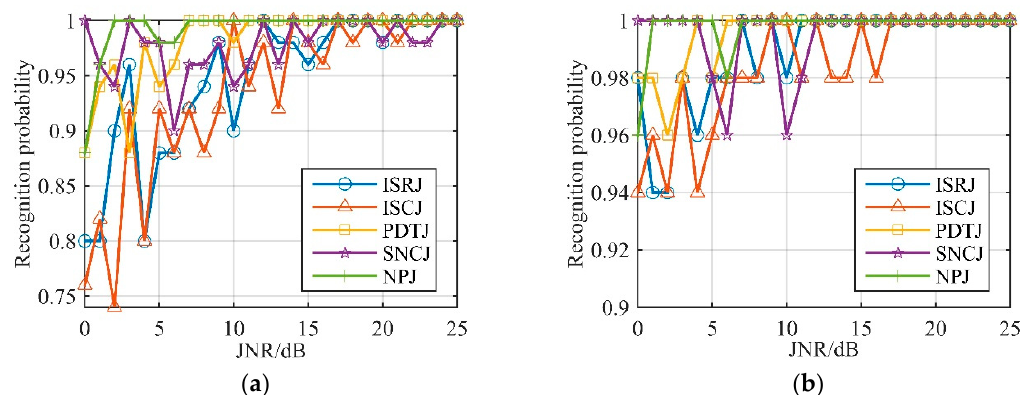
Figure 13. Recognition probability of unconventional active jamming. ( a ) Group 6; ( b ) Group 7.